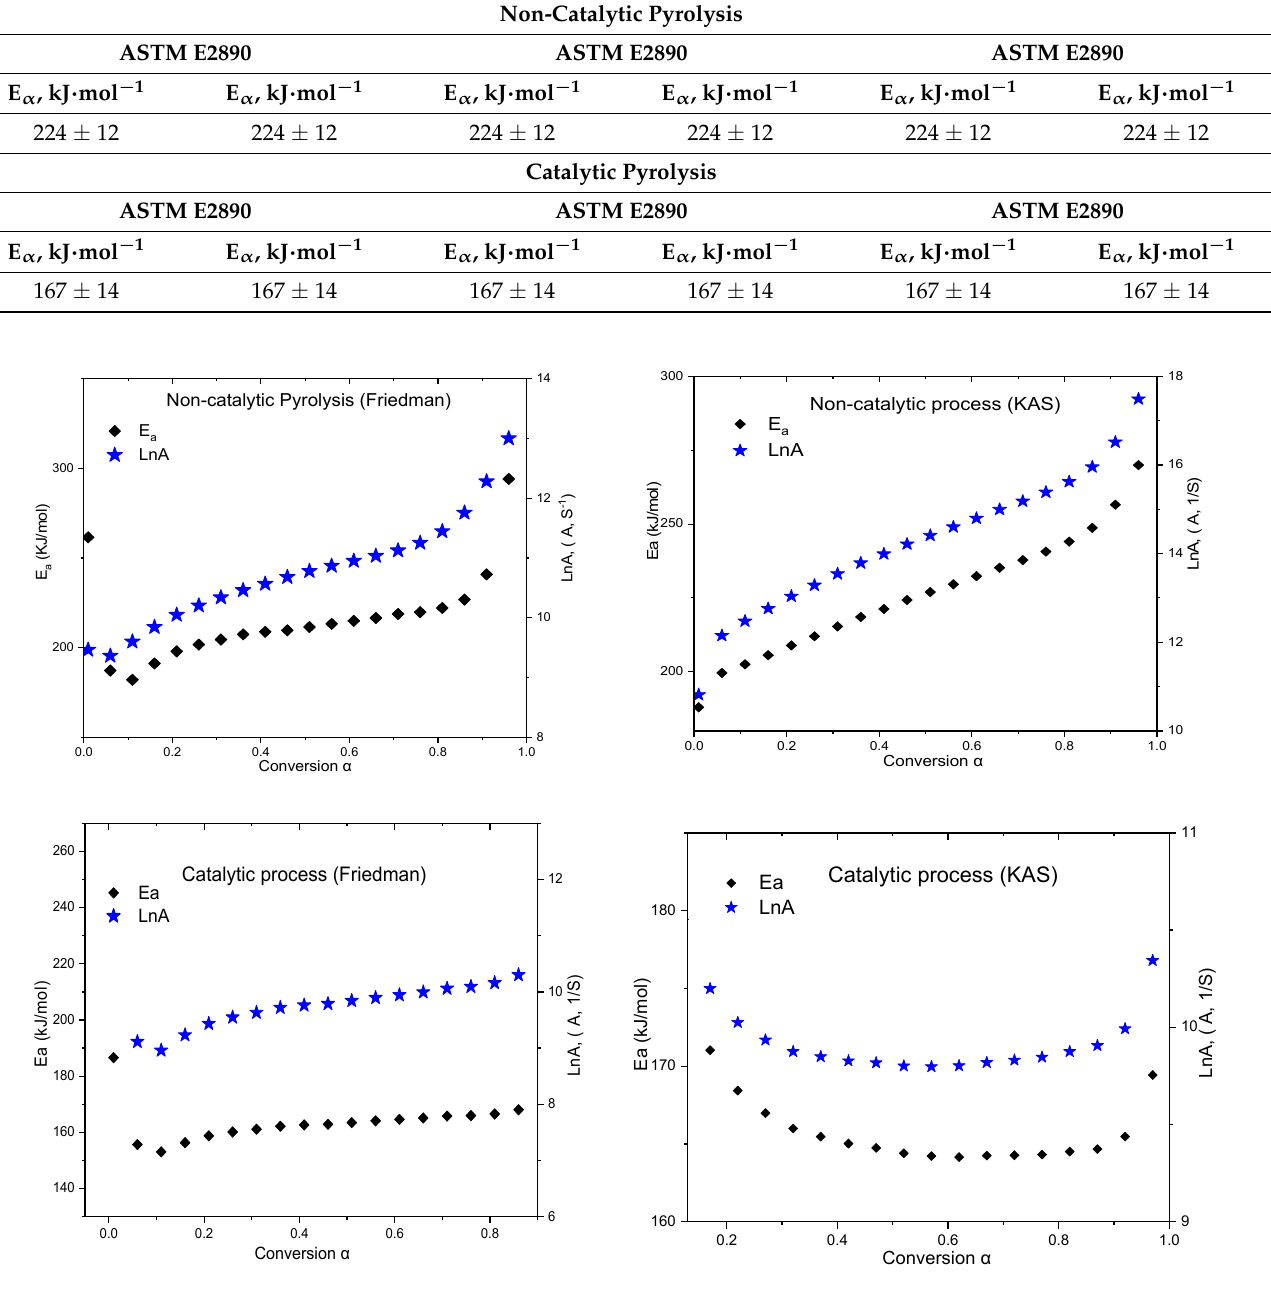
Table 7. Kinetic parameters of Cuban extra-heavy oil pyrolysis process obtained from the isoconversional methods for a conversion degree of 0.5.